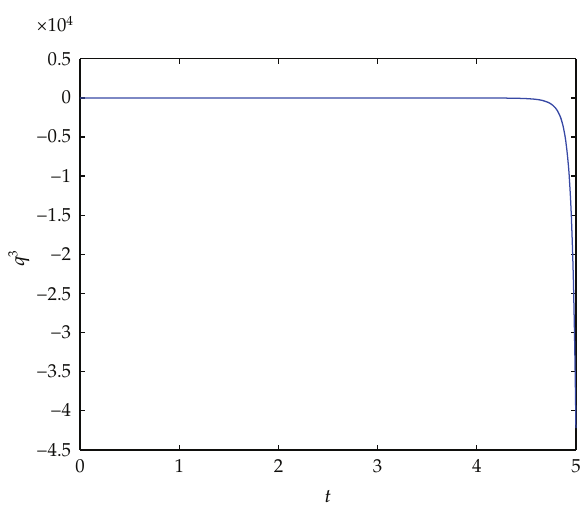
Figure 4: Component q 3 of the